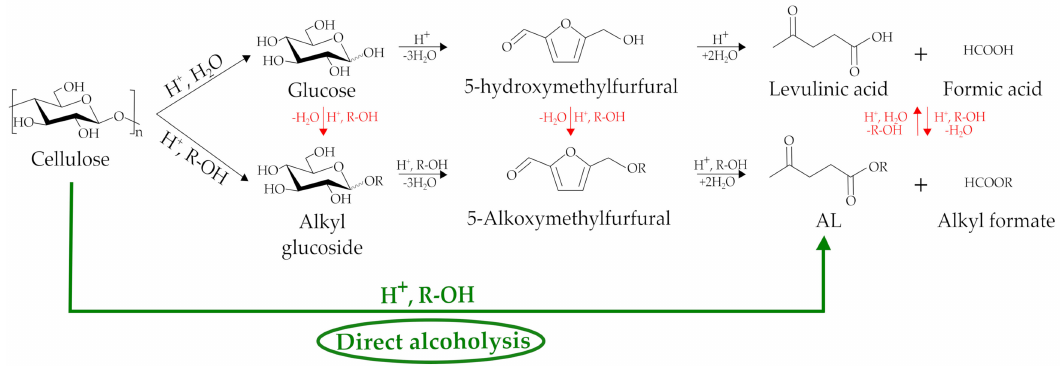
Figure 2. Comparison between the C6 routes for the production of levulinic acid and alkyl levulinate